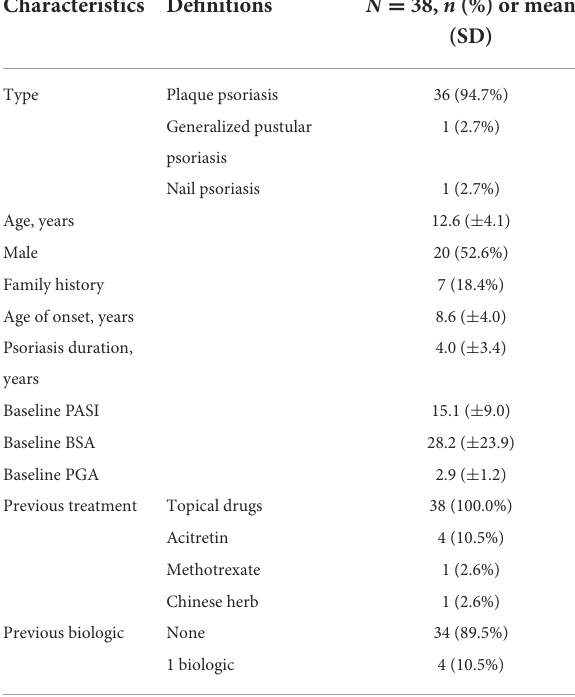
TABLE 1 Demographic data and disease features of the diagnosed children involved in the study. Characteristics